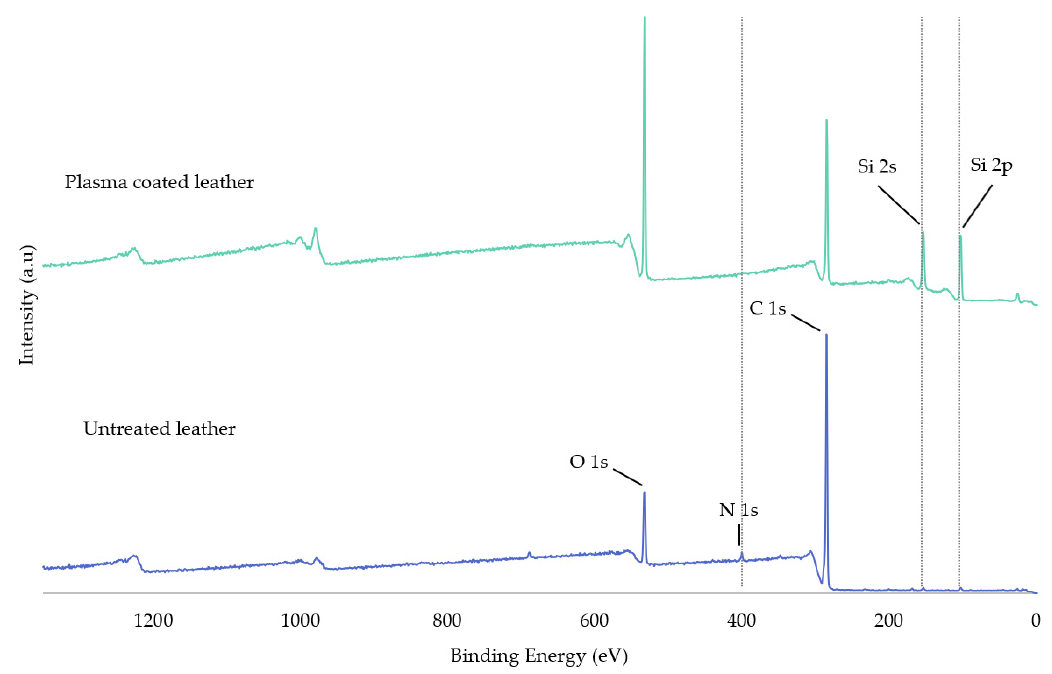
Figure 3. XPS-survey of untreated leather and plasma coated leather with HMDSO. For such purpose, the atomic percentages of the carbon, oxygen, nitrogen, and silicon components were determined and included in Table 4. It should be noted that in the de- convolution of the Si 2p spectrum, four contributions were shown in all samples corre- sponding to Si 2p3/2 and Si 2p1. Since they are doublet pair, to quantify only the most sensitive one, Si 2p3/2 was used. There was 1.12% silicon on the surface of the untreated sample, which may come from the manufacturing of leather or may be due to silicon ex- isting in the analysis XPS chamber. Compared to the untreated sample, the atomic per- centage of silicon in the HMDSO plasma treated sample increased up from 1.12 to 22.39% due to a high deposition of monomer which is composed of silicon components. Moreo- ver, the atomic percentage of C decreased due to the removal and oxidation of organic compounds by the oxygen plasma used in the etching stage, and O increased after plasma treatment due to the introduction of new oxygenated by etching and siliconised molecules deposited on the leather surface, and because of their presence in the polysiloxane com- position. The nitrogen (1.33%) that appeared in the untreated leather is due to the proteins that constitute the original leather. However, in the HMDSO treated sample, 0.25% of ni- trogen was observed. The detection of this small amount of several nitrogenous functional groups in the plasma coated leather could be due to contamination because of the 3–7 nm depth the XPS reaches and the thickness of the deposited HMDSO layer being greatly higher, as can be seen in Section 3.5. Therefore, the amount of nitrogen obtained in the coated sample can be considered negligible, indicating that no signal from the XPS-based substrate has been obtained and uniform coverage has been made on the substrate during plasma deposition. Furthermore, the atomic ratios showed an increase in the percentage of oxygen and silicon and a decrease in the atomic percentage of carbon due to the named chemical modifications [14,15,49].